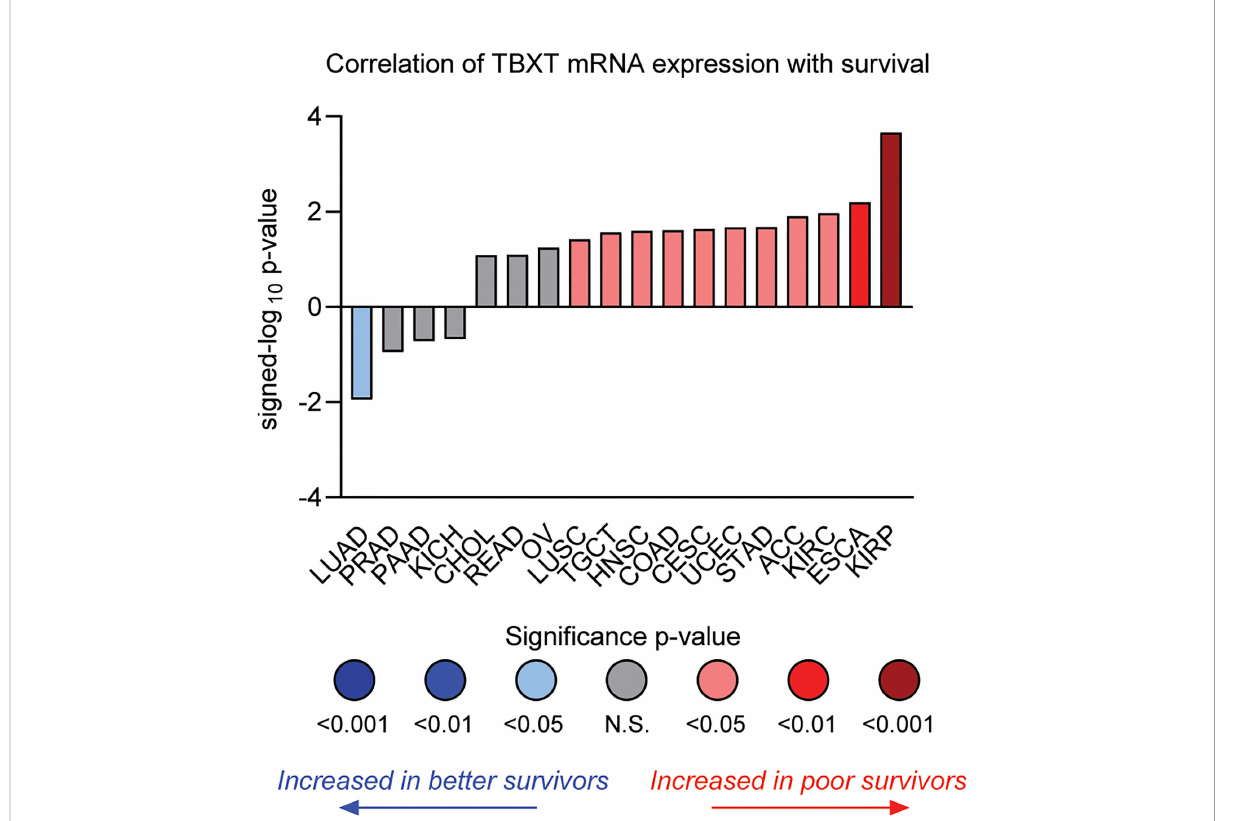
FIGURE 4 Correlation of TBXT (brachyury) mRNA expression with overall survival by tumor type in TCGA datasets. The individual values are sign-corrected log 10 p-values of correlation. Negative signed-log 10 p-values (y-axis) indicate that high TBXT expression is associated with better survival, whereas positive values indicate high TBXT expression predicts poor survival. Cancer types are listed by their respective TCGA study abbreviations (e.g., KIRP, kidney renal papillary cell carcinoma; ESCA, esophageal carcinoma; KIRC, kidney renal clear-cell carcinoma; LUAD, lung adenocarcinoma). The results shown in this fi gure are in whole or part based upon data generated through the Lumin Bioinformatics Software of Champions Oncology,